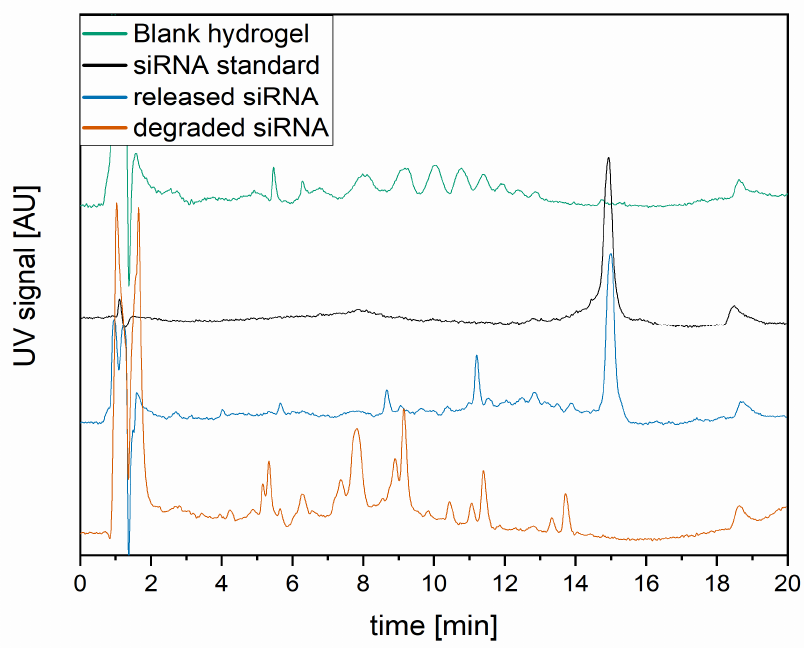
Figure 4. HPLC chromatograms from stability experiments of loaded siRNA in hydrogels ( blue ), compared to the siRNA standard ( black ), blank from unloaded hydrogel formulation ( green ), and degraded siRNA ( orange ).